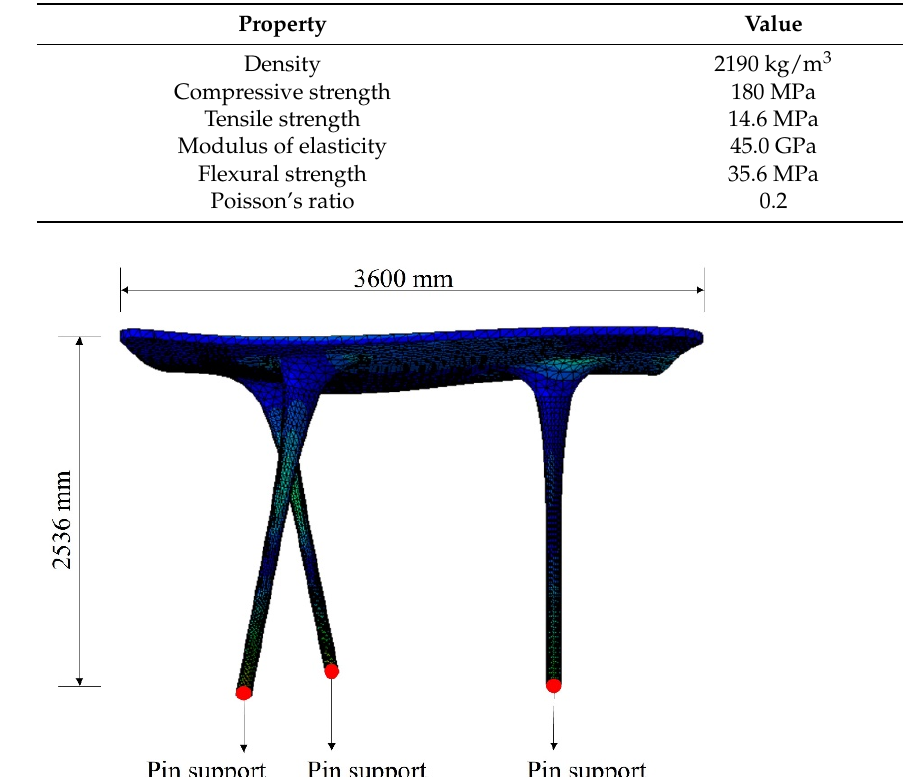
Figure 15. Finite element model.